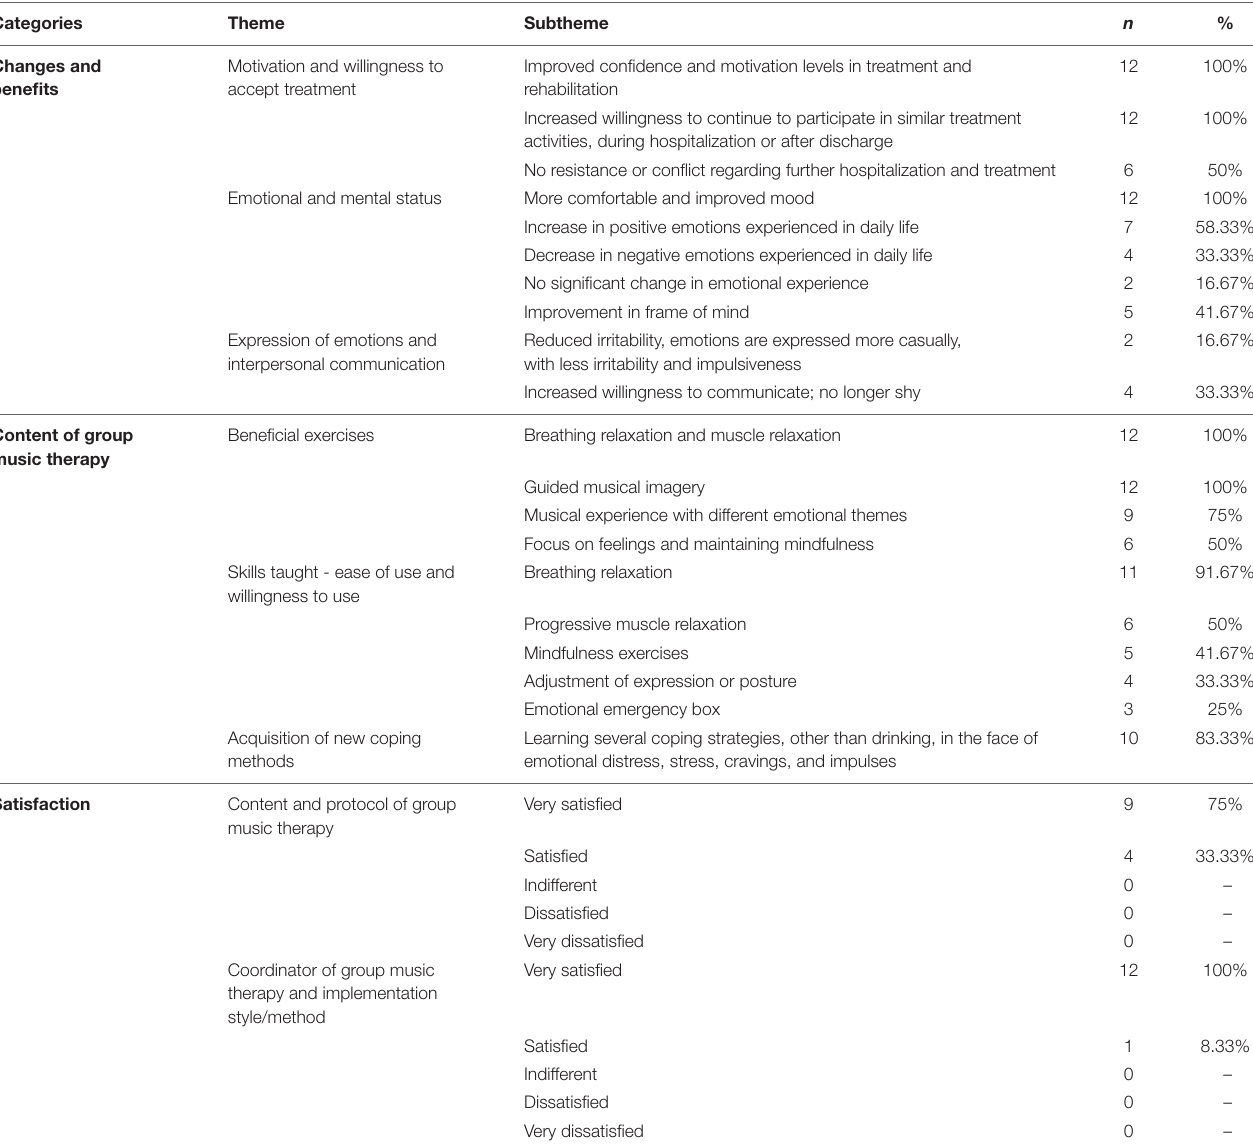
TABLE 3 | Qualitative assessment of group music therapy administered to 12 male inpatients with alcohol dependence (AD).